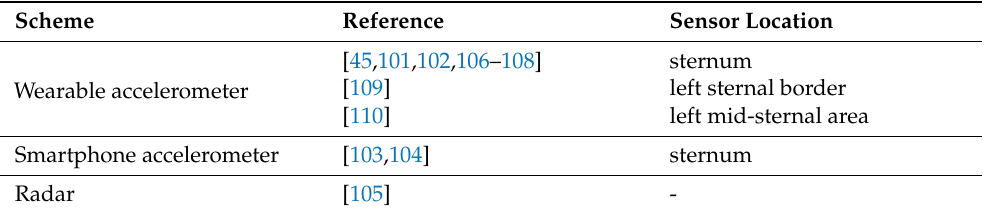
Table 3. Summary of SCG sensors’ diversity in the articles